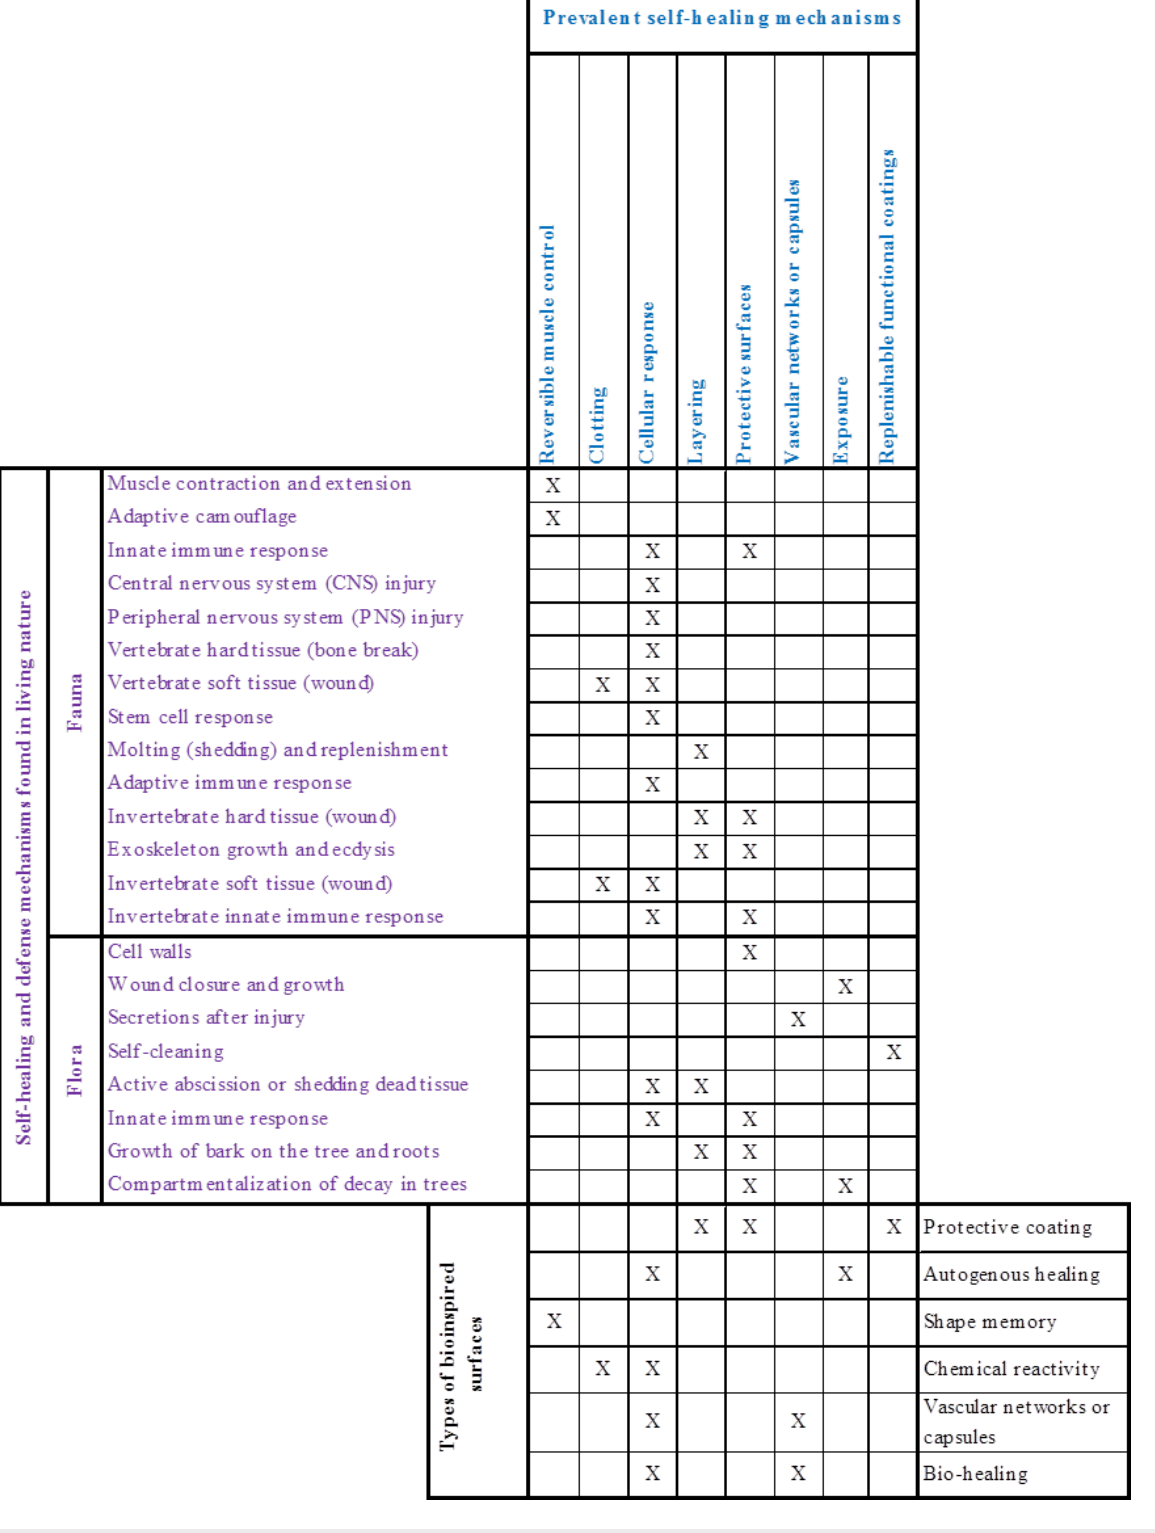
Figure 13: Chart relating self-healing and defense mechanisms found in living nature with prevalent self-healing mechanism categories with bioin- spired types of synthetic